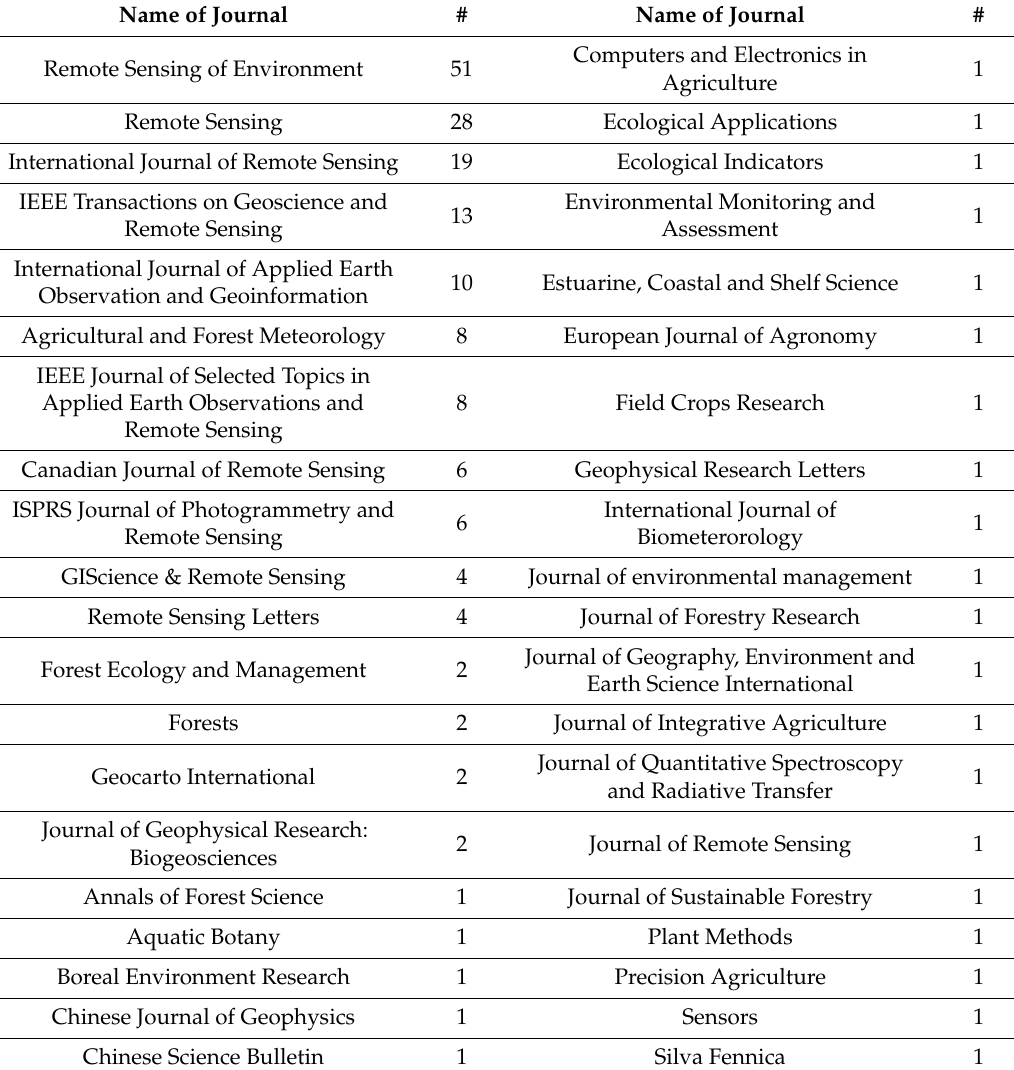
Table 1. Journal list and the number of papers (#) for forest and crop LAI estimation from